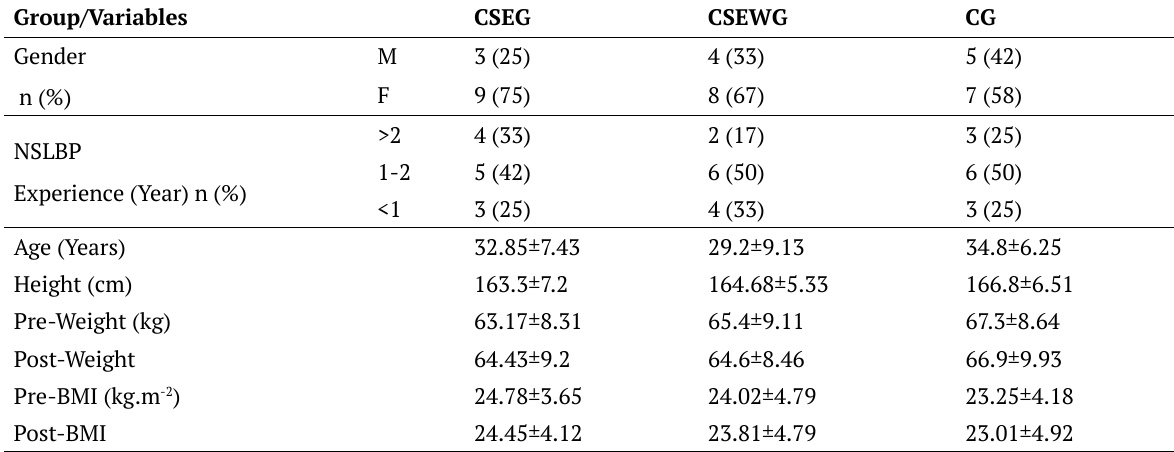
Table 2. Demographic data of participants by group (Mean±SD) Group/Variables